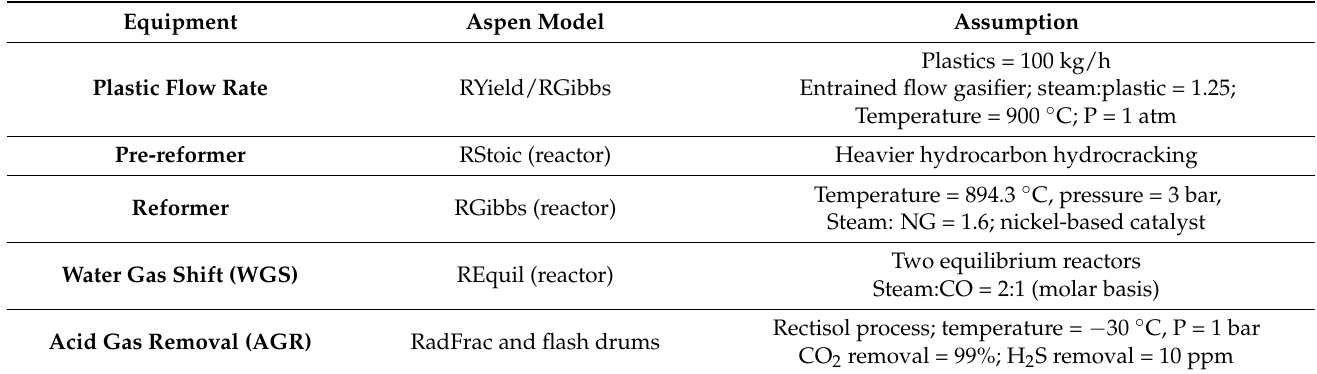
Table 2. Design assumptions made for case 1 and case